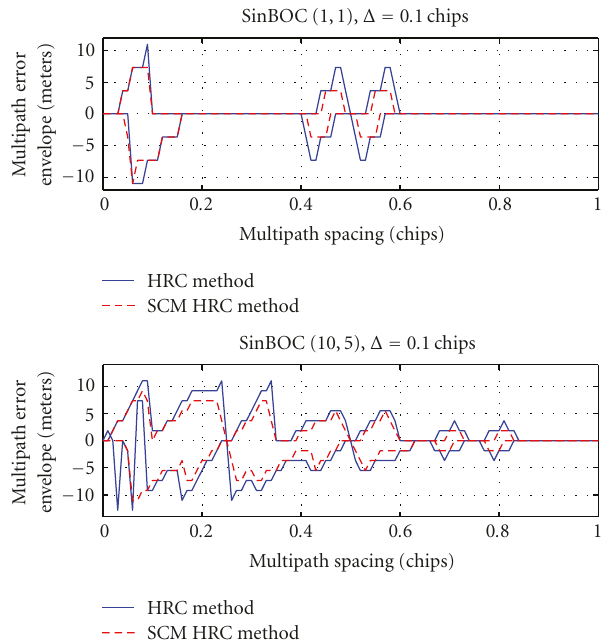
Figure 14: Multipath error envelopes (in meters): HRC method versus SCM HRC method, for two BOC-modulation cases and Δ = 0 . 1 chips.